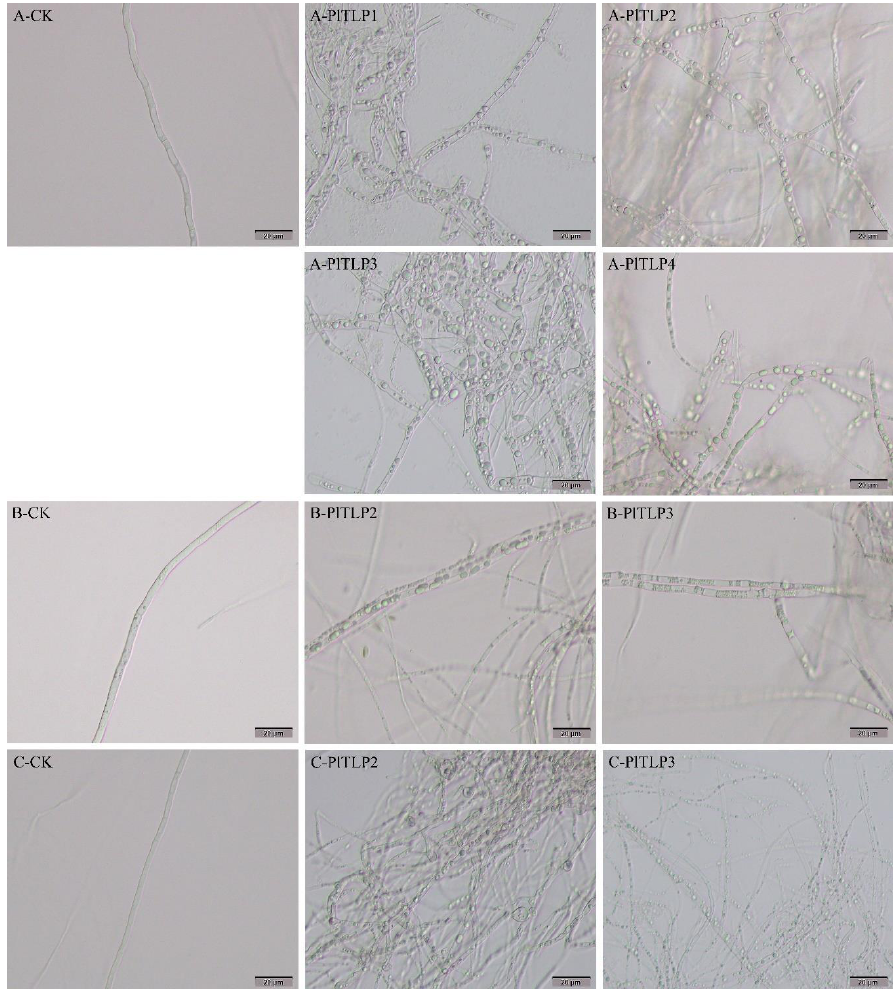
Figure 8. Effect of recombinant PlTLP proteins on fungal hyphae morphology. ( A-CK/PlTLP1–4 ) L. piceae , ( B-CK/PlTLP2,3 ) F. proliferatum , ( C-CK/PlTLP2,3 ) R. doimaesalongensis . CK: The fungal hyphae were treated with ddH 2 O at 25 ◦ C for 48 h. PlTLP1–4: The fungal hyphae were treated